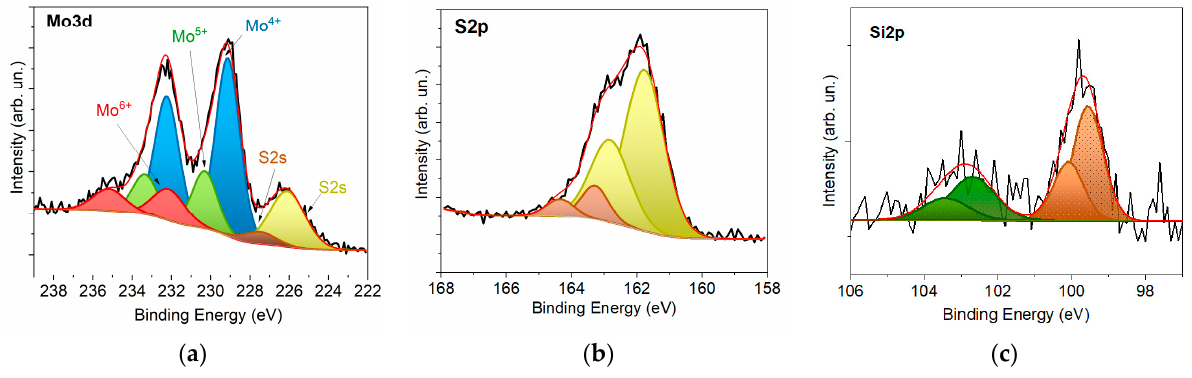
Figure 12. XPS ( a ) Mo3d, ( b ) S2p, and ( c ) Si2p spectra for the surface of a-MoS x /NP-Mo//n + p-Si cathode (with a 4 nm thick film), measured after testing in a photoelectrochemical cell for 20 min.